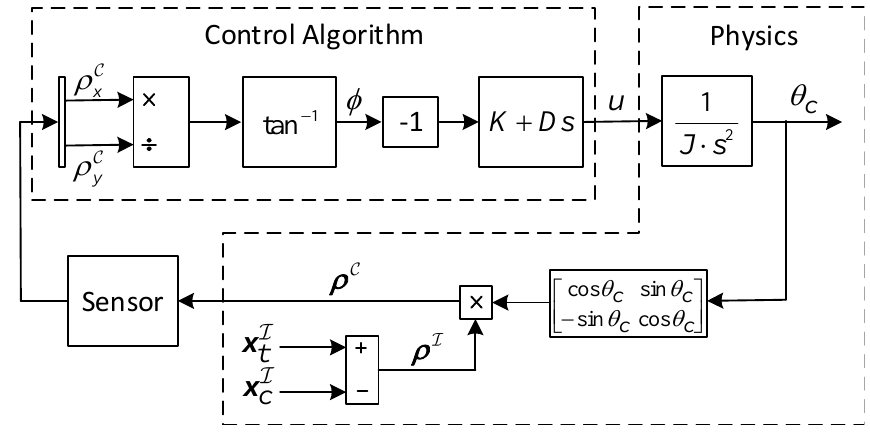
Figure 7. The LOS Control